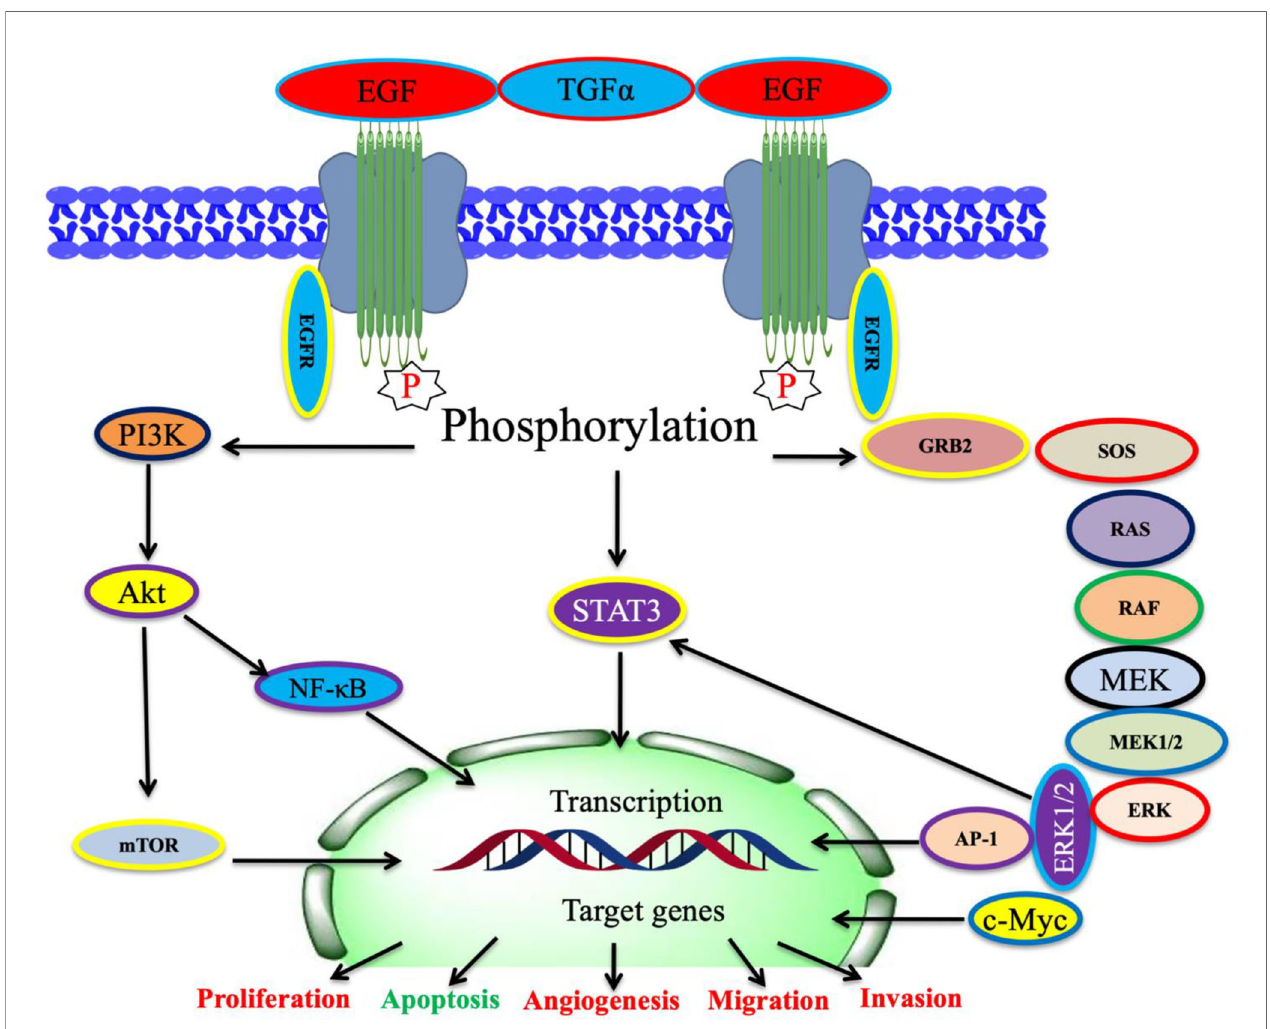
FIGURE 2 | The EGFR receptor and its signaling cascade involved in cancer progression. (This fi gure is adapted from Ref 97 –